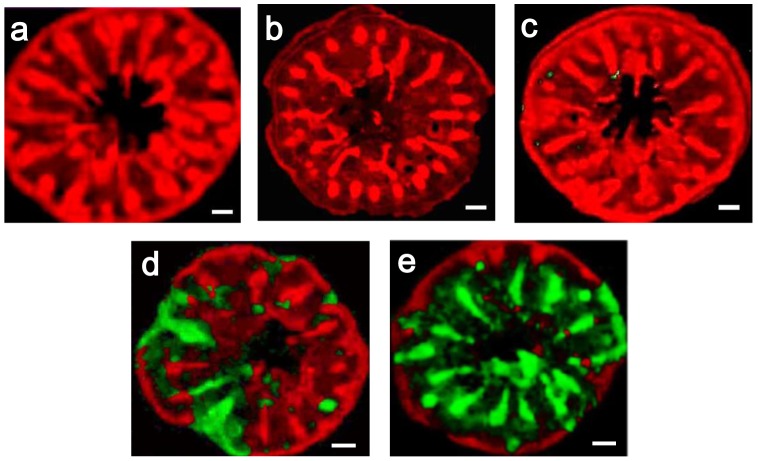
Raman mapping images of juvenile skeletons of Acropora tenuis.Scale bars are 100 µm. Red: aragonite, green: calcite. To classify Raman spectrum of calcite and aragonite, multivariate analysis was conducted. (a) mMg/Ca = 5.3 (#1, Table 1); (b) mMg/Ca = 2.7 (#2); (c) mMg/Ca = 1.5 (#3); (d) mMg/Ca = 1.0 (#4); (e) mMg/Ca = 0.5 (#5).